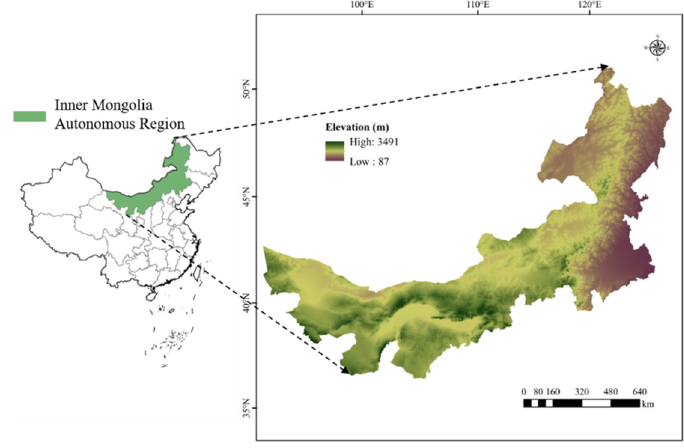
Figure 1. The location of the study area.